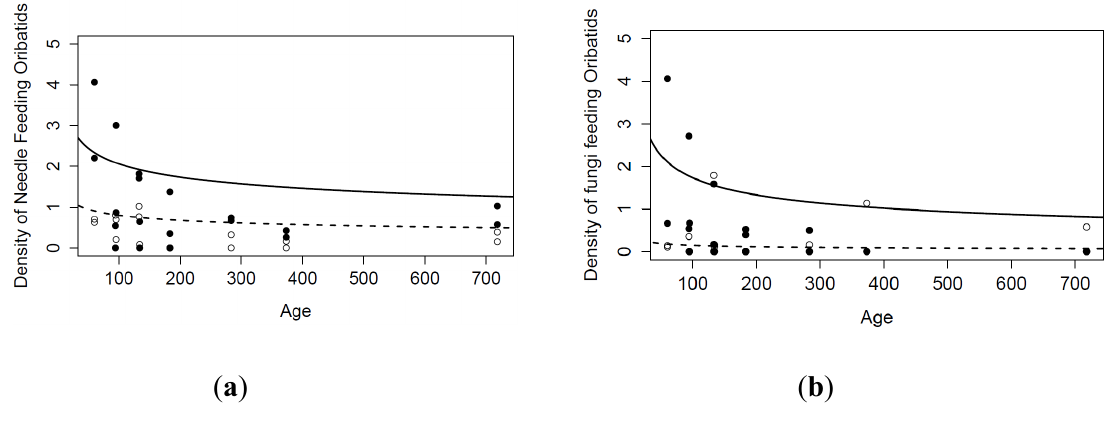
Figure 3. Density (individuals/g of dry substrate) of ( a ) litter feeder and ( b ) fungi feeder oribatids plotted against stand age (years since fire). Black dots correspond to adjacent position relative to CWM and open circles to samples under CWM. The solid line corresponds to the line of predicted values for adjacent samples while the dashed line corresponds with the predicted values from the mixed model for samples under